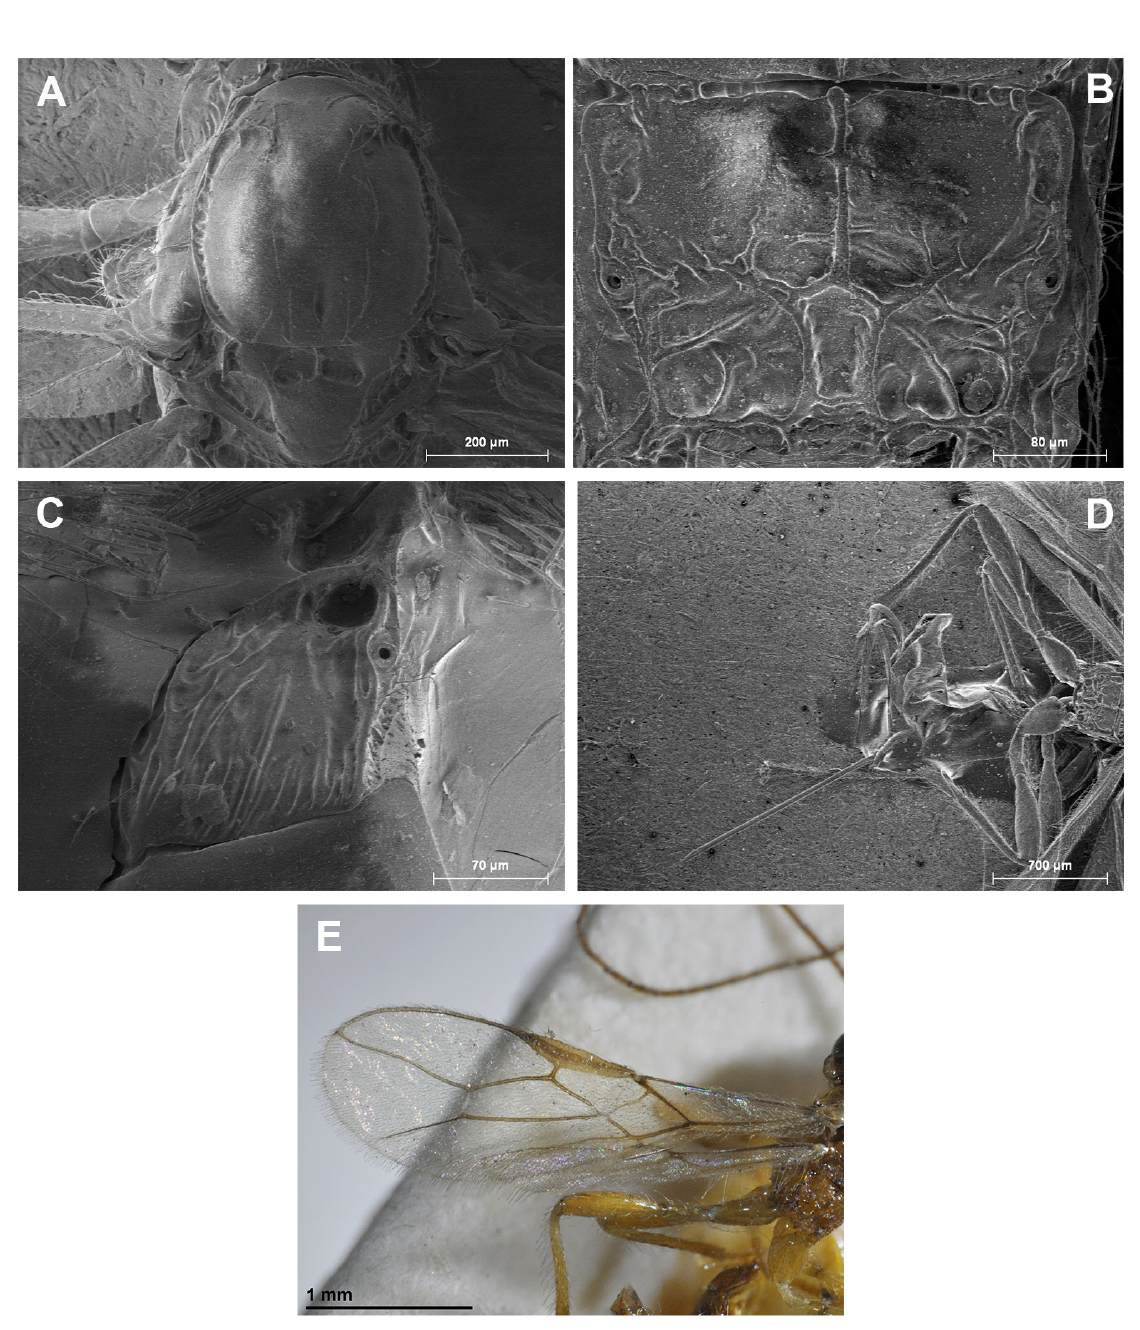
Fig. 34. Asobara kovacsi (Papp, 1966), ♀, holotype (HNHM). A . Mesoscutum, dorsal view. B . Propodeum, dorsal view. C . First metasomal tergite, dorsal view. D . Hind leg, metasoma and ovipositor, lateral view. E . Fore